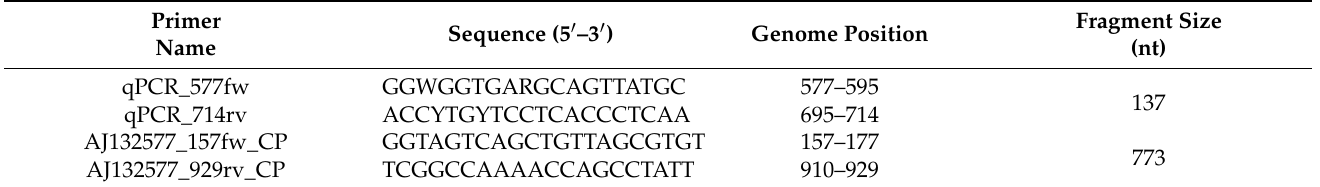
Table 2. Degenerate real-time PCR primers for detection of SBCMV and primers for amplification of the complete coat protein gene.